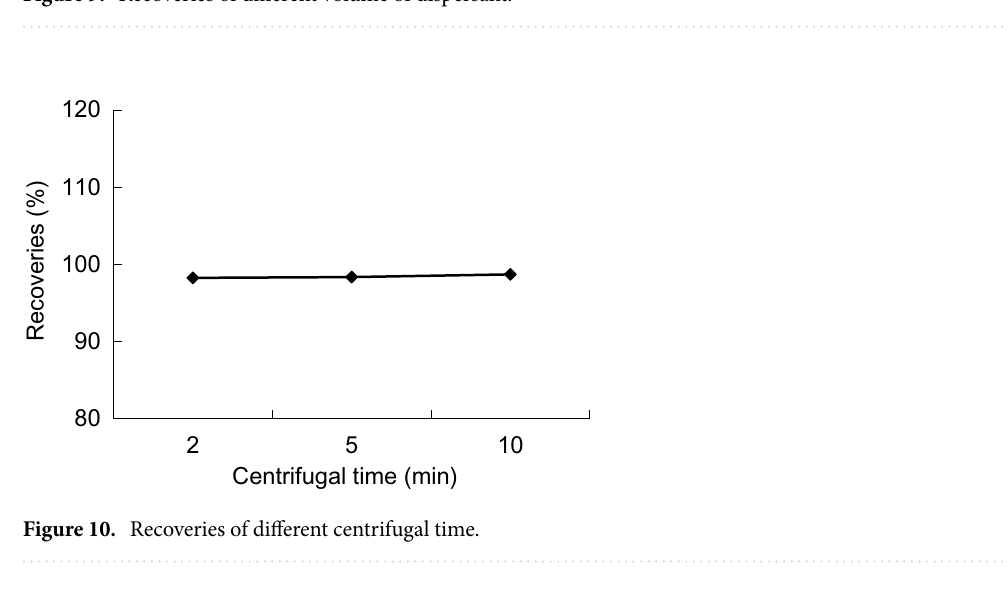
Figure 9. Recoveries of different volume of dispersant.